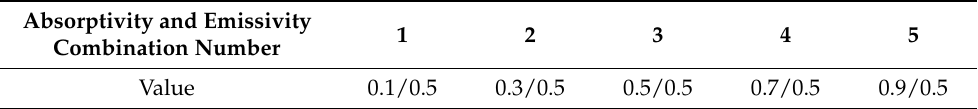
Table 2. The absorptivity and emissivity (=0.5) combination